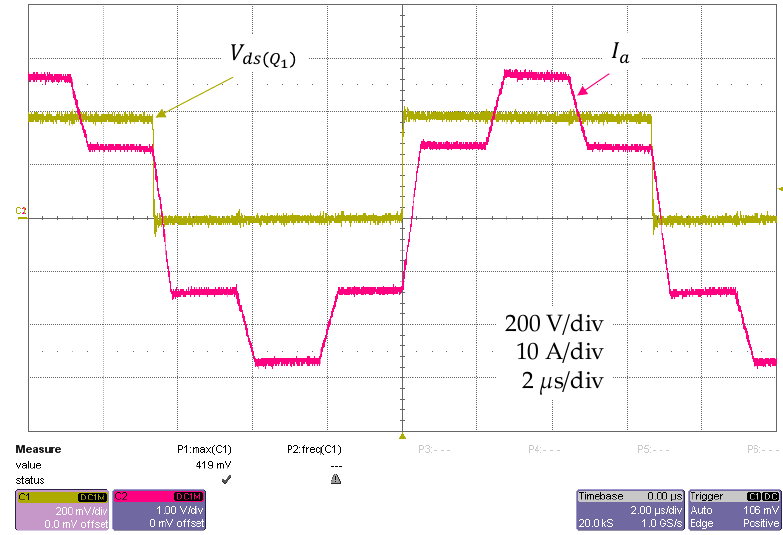
Figure 11. Voltage and current waveforms at 9.3